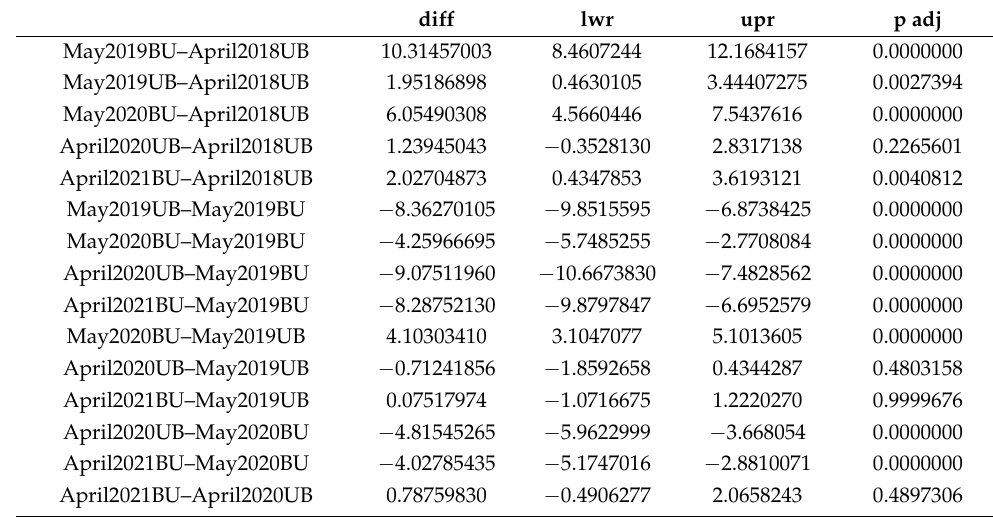
Table A5. Significance parameters of post-hoc Tukey analysis, UB = Unburned, BU =